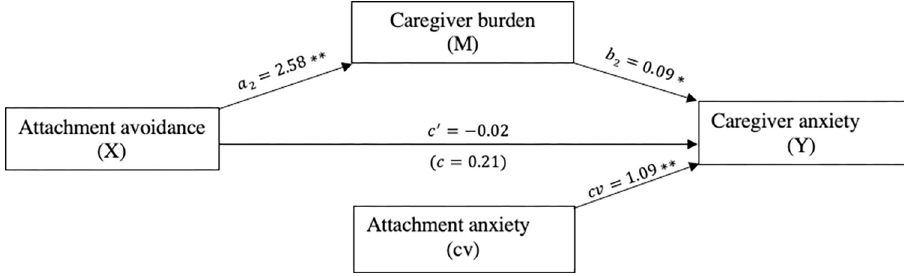
Fig 3. The mediating effect of caregiver burden in the relationship between attachment avoidance and caregiver anxiety. � p < 0.05, �� p < 0.001, cv = covariate.